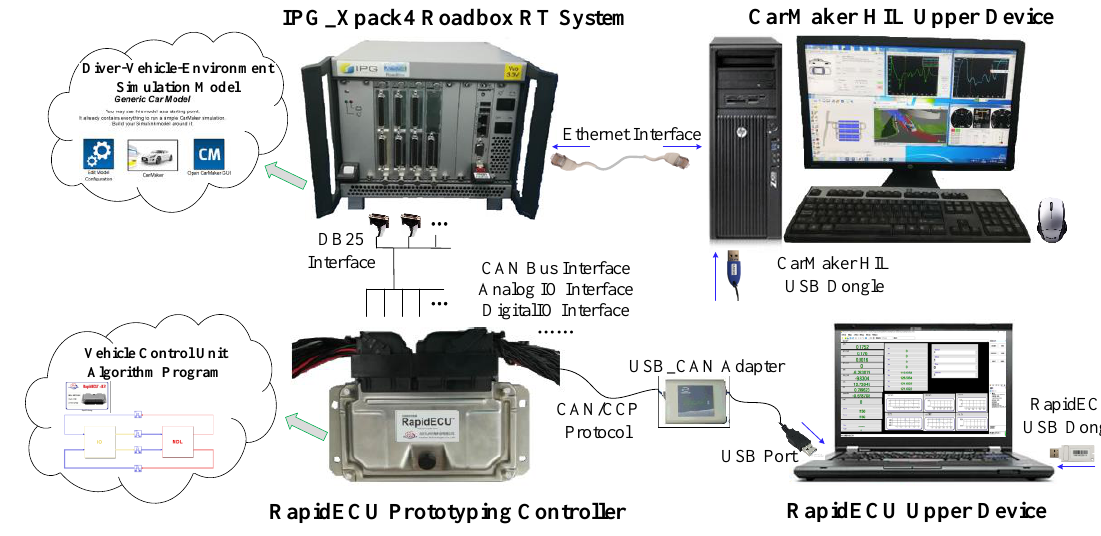
Figure 13. The HIL platform for the CIL test.